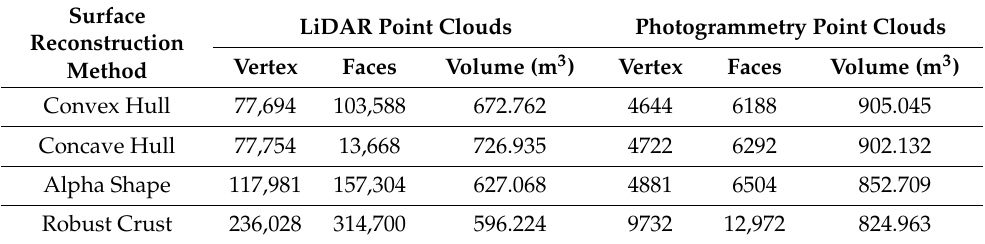
Table 5. The number of vertices, faces, and volumes generated for each surface reconstruction